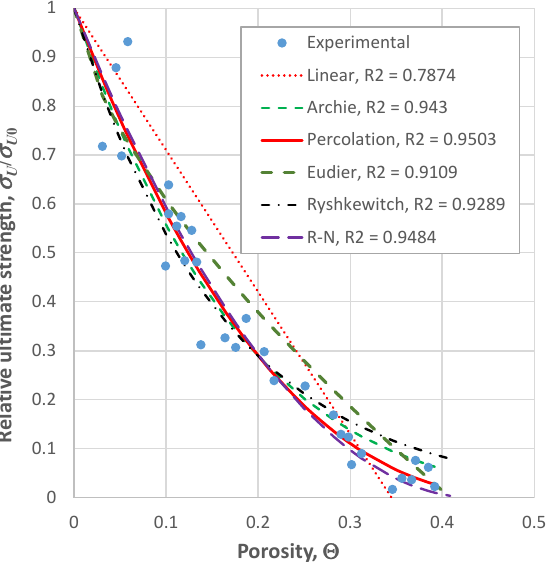
Figure 3. Experimental values of the relative ultimate strength vs. porosity [56], and fitting with the linear law, Archie’s law (Bal’shin), percolation law, Ryshkewitch’s law, Eudier’s law and Rzhevsky-Novik’s law.